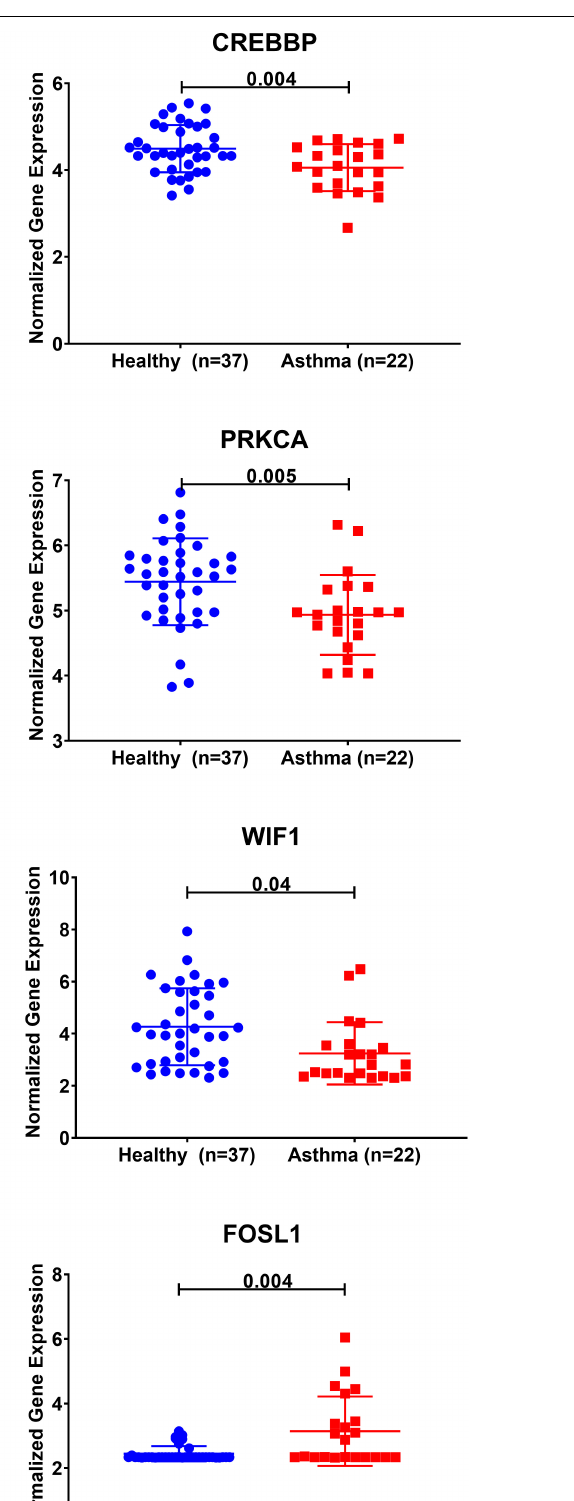
Frontiers in Cell and Developmental Biology |